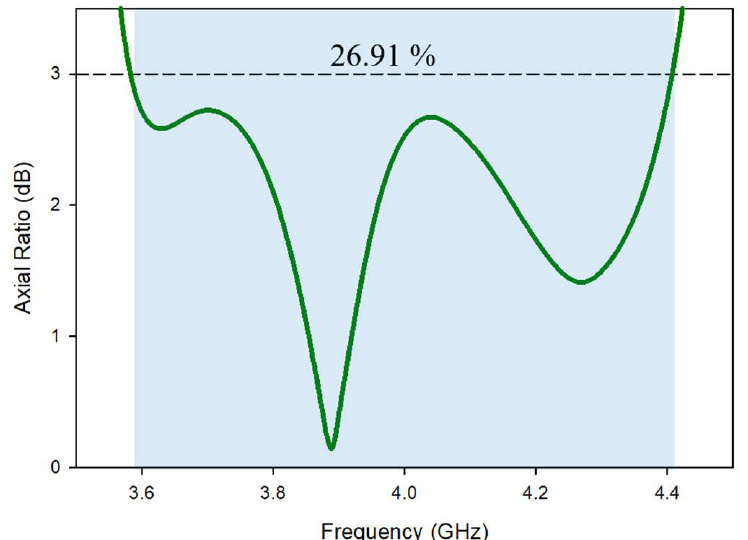
Figure 13. Axial ratio of the proposed antenna.